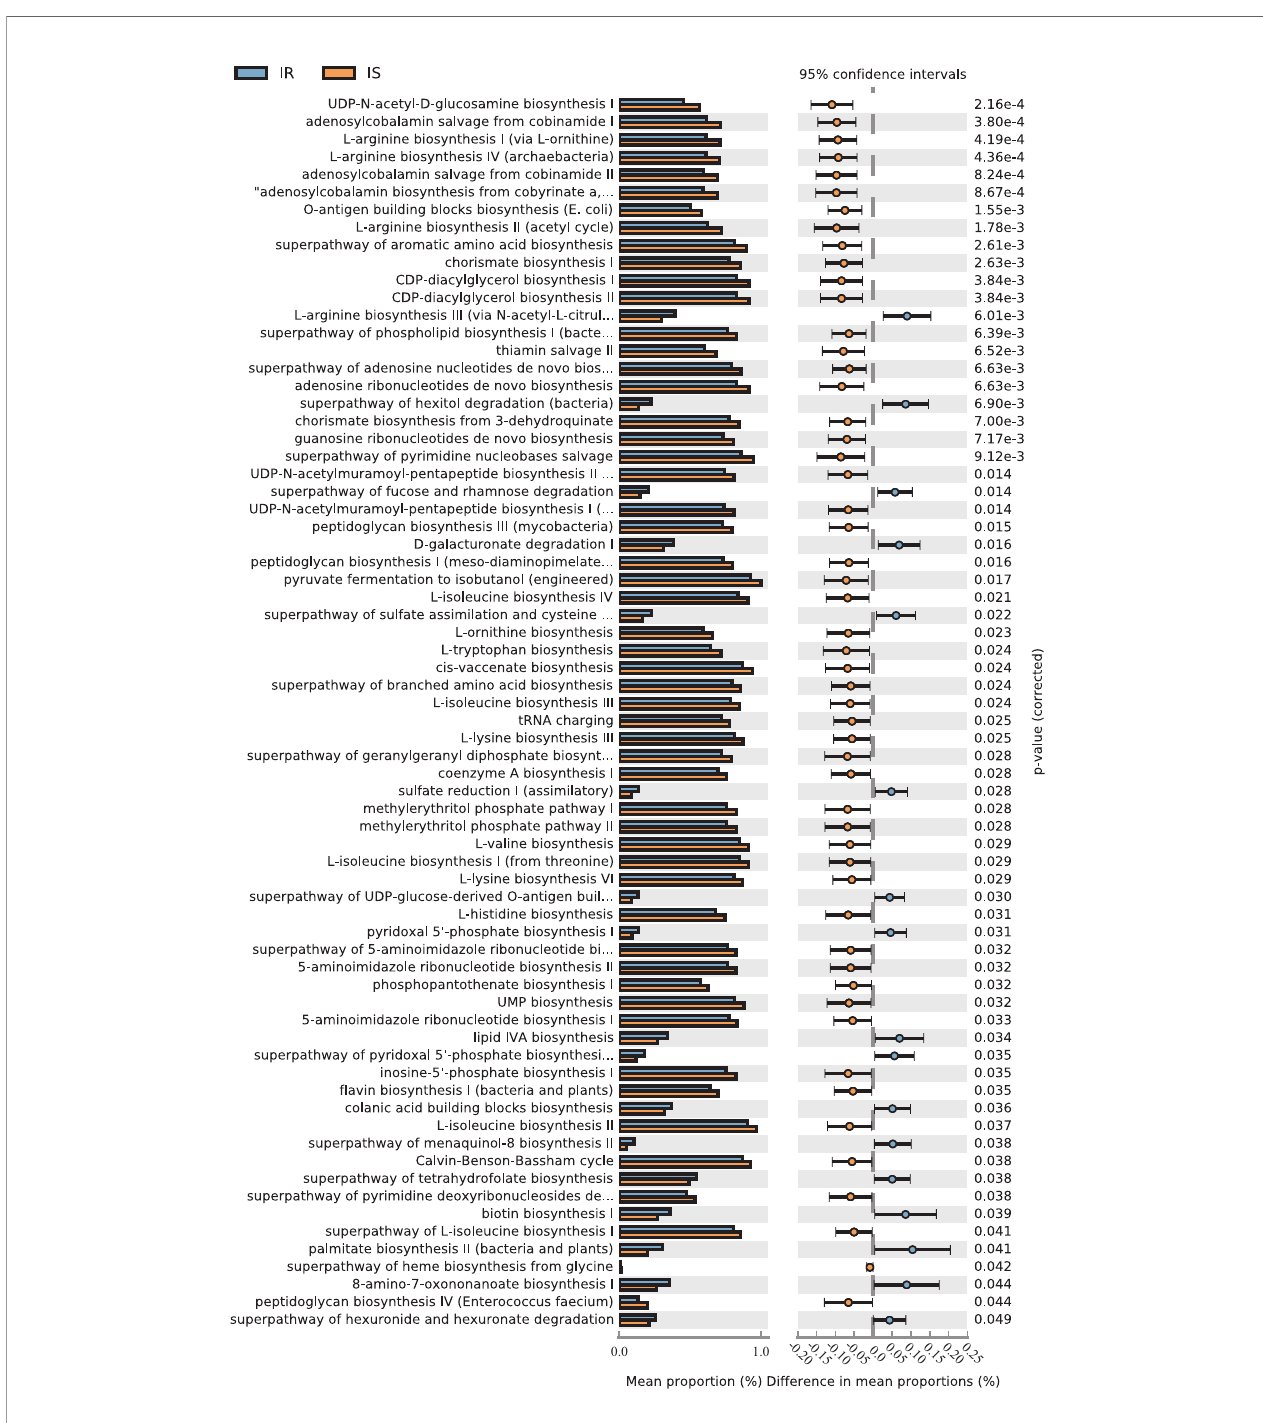
FIGURE 4 | KEGGs biomarkers of IR and IS